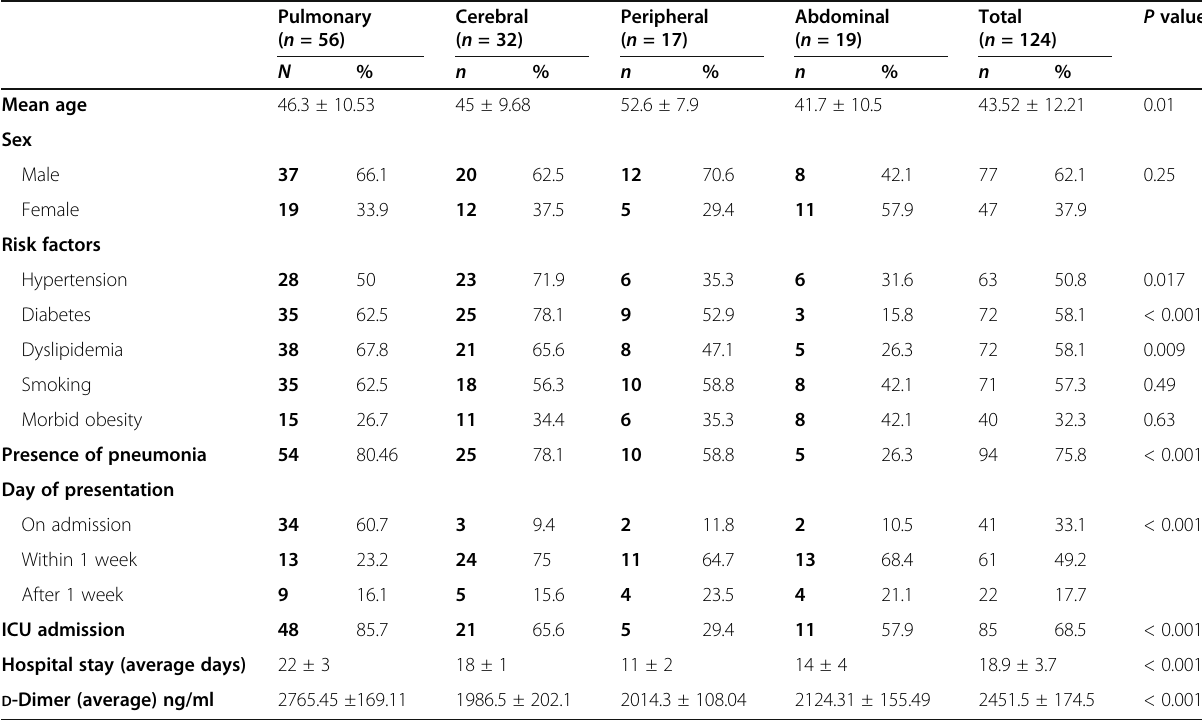
Table 1 Demographic data of the